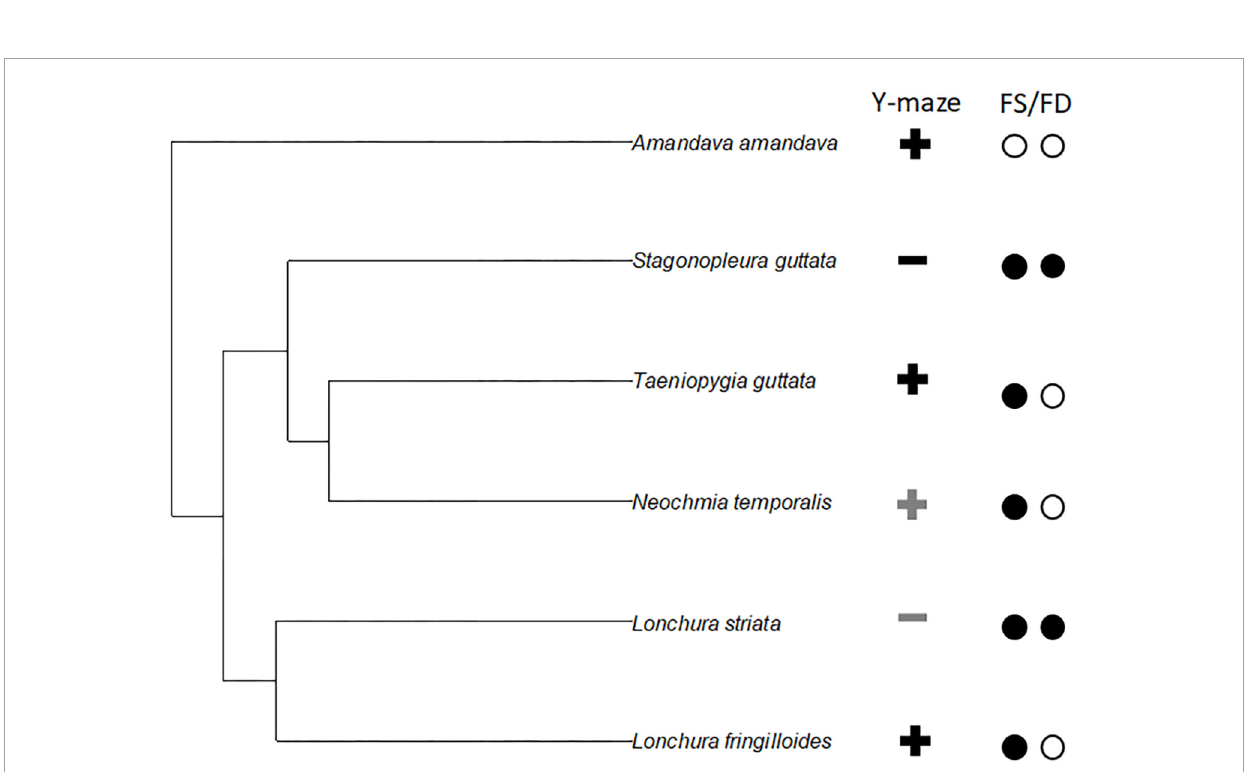
FIGURE3 An exemplary phylogenetic tree for the six used Estrildid Finch species, Zebra Finch ( Taeniopygia guttata ), Diamond Firetail ( Stagonopleura guttata ), Bengalese Finch ( Lonchura Striata var domestica ), Red-browed Finch ( Neochmia temporalis ), Red Avadavat ( Amandava amandava ), and Magpie Manakin ( Lonchura fringilloides ). For the exemplary phylogenetic tree, a random Hackett tree (Jetz et al., 2012) was plotted using the R-package “ape” (Paradis et al., 2004). The symbols in the columns on the right indicate for the respective species the following. Y-maze: “+” indicates that birds from that species chose more likely same sexed birds, if coloured in grey this is only true for one of the two sexes and the other sex was not different. “ − “ indicates that birds from that species chose more likely opposite sexed birds, if coloured in grey this is only true for one of the two sexes and the other sex was not different. The open circles indicate the presence of a female song/female dance (FS/FD in this species, while the black circles indicate its